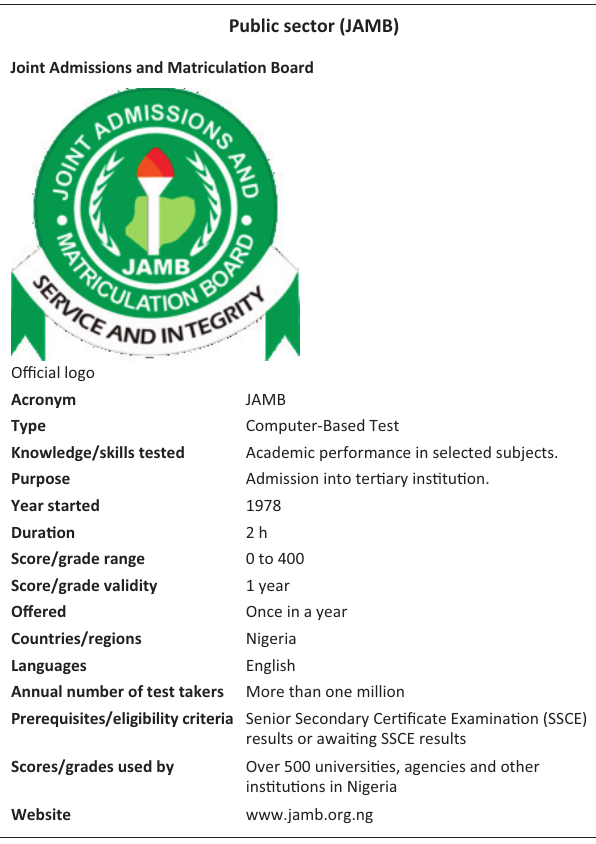
FIGURE 3: Public Sector: Joint Admissions and Matriculation Board JAMB, Joint Admission and Matriculation Board; Senior School Certificate Examination